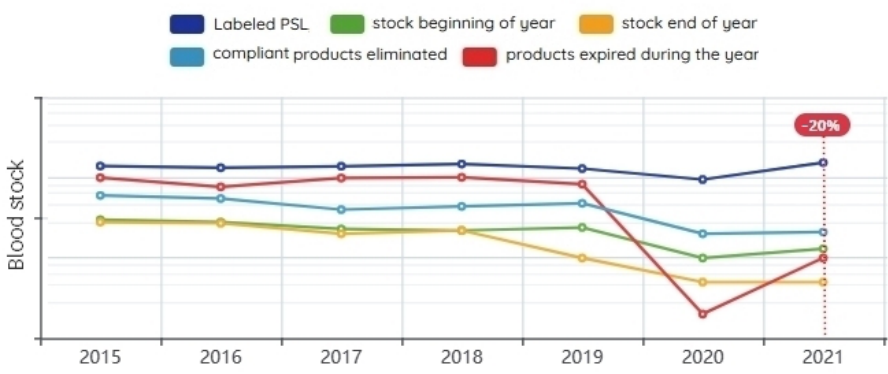
Figure 12. Blood inventory